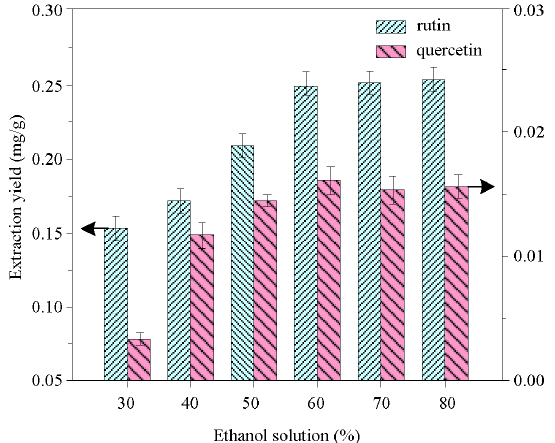
Figure 3. Effect of concentration of ethanol solution using 80 kHz ultrasonic frequency at 30 ◦ C for 30 min on the extraction of quercetin and